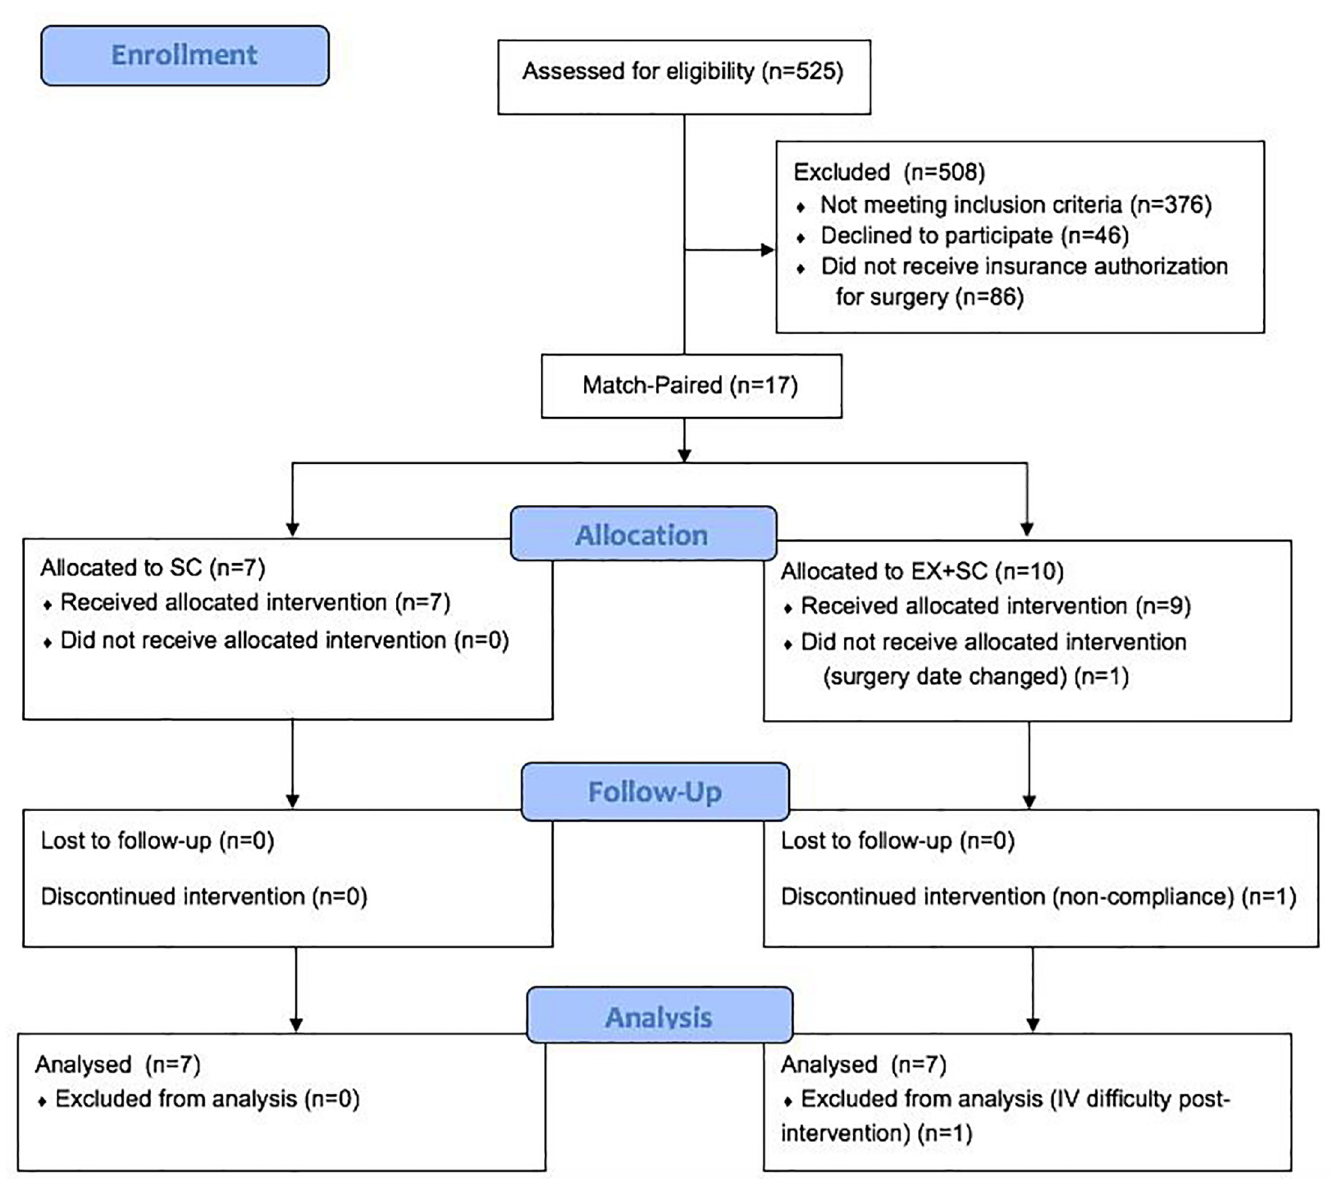
Fig 1. CONSORT flow